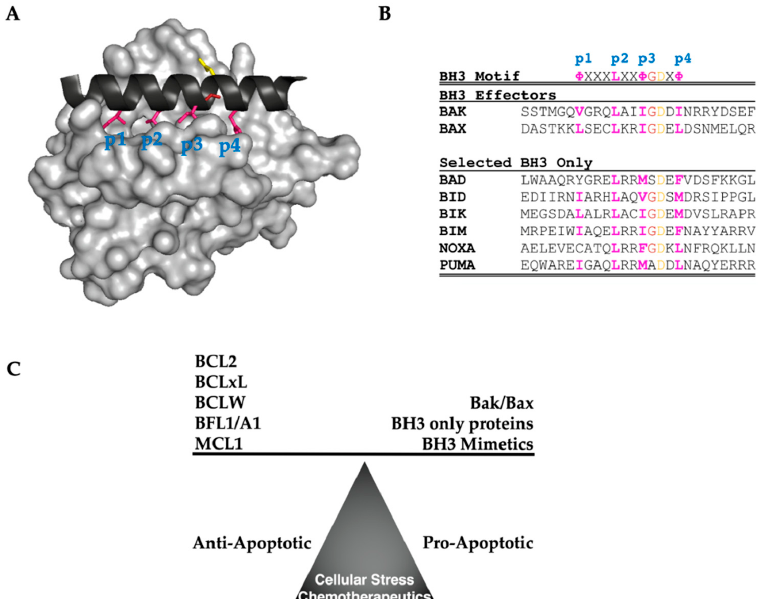
Figure 2. BCL2 Family Structure, Function, and Equilibrium. ( A ) Surface structure of MCL1 (grey) with BH3 binding pocket, representative of the anti-apoptotic BCL2 family, bound to BIM BH3 Only protein (Black) with highlighted residues: Hydrophobic (Pink), conserved Glycine (red), and invariant Aspartic Acid (Yellow). [PDB: 2NL9] ( B ) BH3 Sequence homology between BCL2 effectors and selected BH3 Only proteins. ( C ) BCL2 Family Interactions Balance Cell Stress Signaling, where BCL2 family stoichiometry and affinity dictate cell fate.